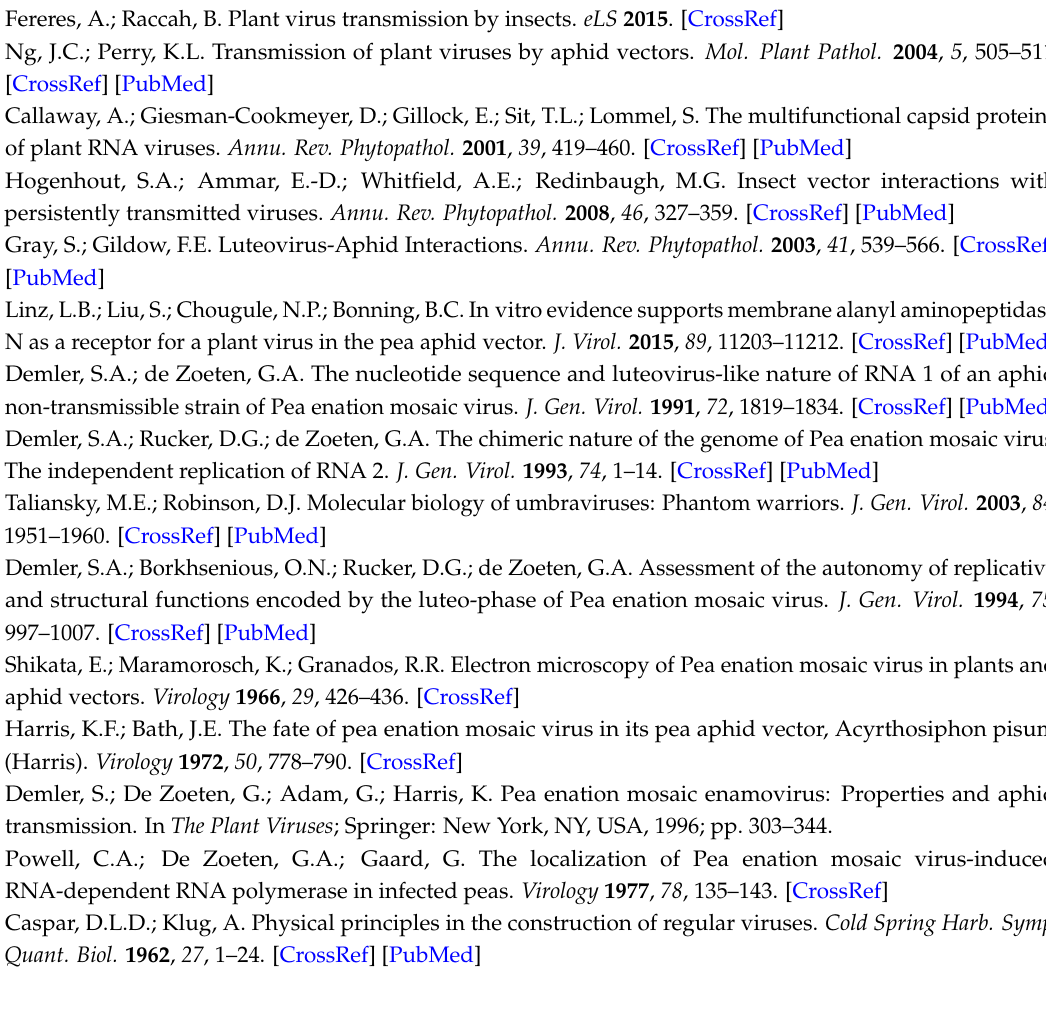
Figure S1: Predicted 3D structure of PLRV coat protein (CP) and comparison to PEMV CP; Figure S2: Overlay of predicted 3D structures of PEMV1 coat protein (CP) using Phyre2 and I-TASSER servers; Figure S3: Accumulation of wild-type and mutant PEMV within inoculated leaves relative to β -tubulin reference; Figure S4: Accumulation of wild-type and mutant PEMV within upper leaves of inoculated pea plants relative to β -tubulin reference; Figure S5: Detection of virion structural proteins following aphid inoculation of pea plants with wild-type or CP mutants by western blot; Table S1: Specific amino acid changes made for each of the 16 mutations made in PEMV CP; Table S2: Sequences of primers used for generation of mutant PEMV-1; Table S3: Sequences of primers used for quantification of PEMV1 and 2, and of transcripts for two housekeeping